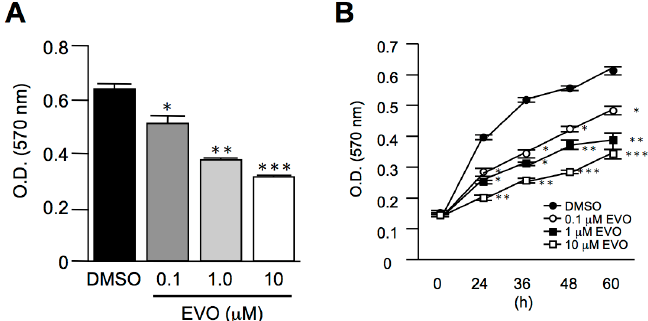
Figure 2. Evodiamine inhibited Homo sapiens hepatocellular carcinoma, HepG2 cell proliferation. Homo sapiens hepatocellular carcinoma and HepG2 cells were treated with different doses of evodiamine for 24 h ( A ) or treated with 10 μ M evodiamine and harvested at the indicated periods ( B ). The cells were then incubated with 0.2 mg/mL MTT in culture medium for three hours. The absorbance was measured at a wavelength of 570 nm. The data are expressed as means ± S.E.M. and obtained from two independent experiments with three replicates for each experiment. * p < 0.05,